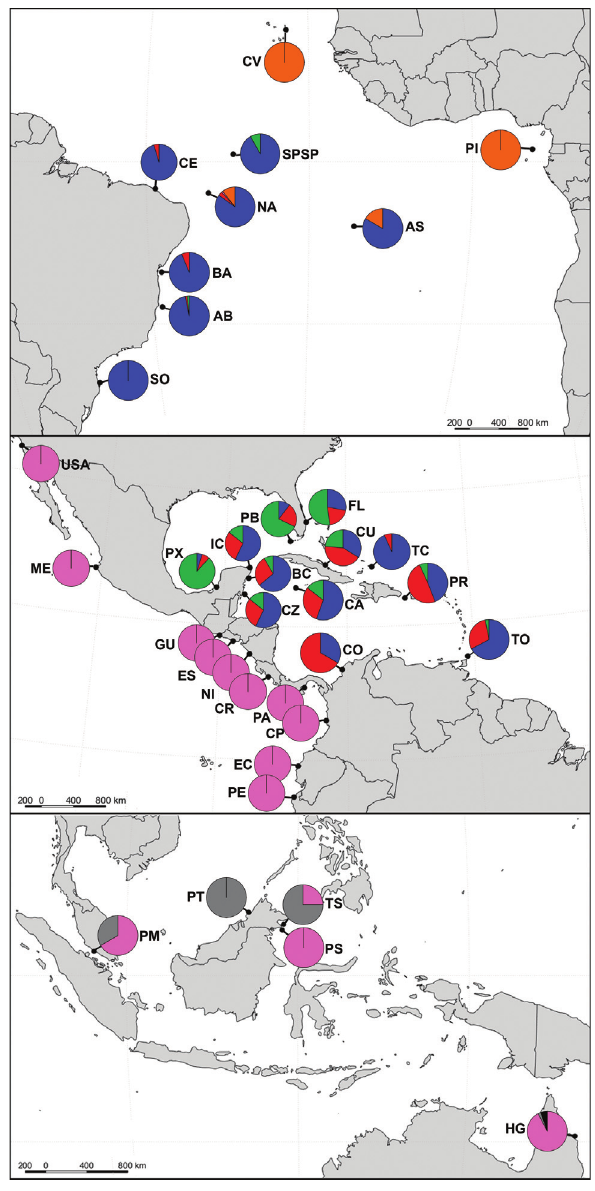
Figure4 -Frequenciesofcontrolregionhaplotypes(739bp)intheforaging aggregations of Caribbean and Eastern Pacific (upper), South and Eastern Atlantic (middle) and Indo-Pacific basins (lower). The haplotypes were grouped and colored according to the genetic lineage identified by phylo- genetic analysis (see Figure 1). See Table S3 for location